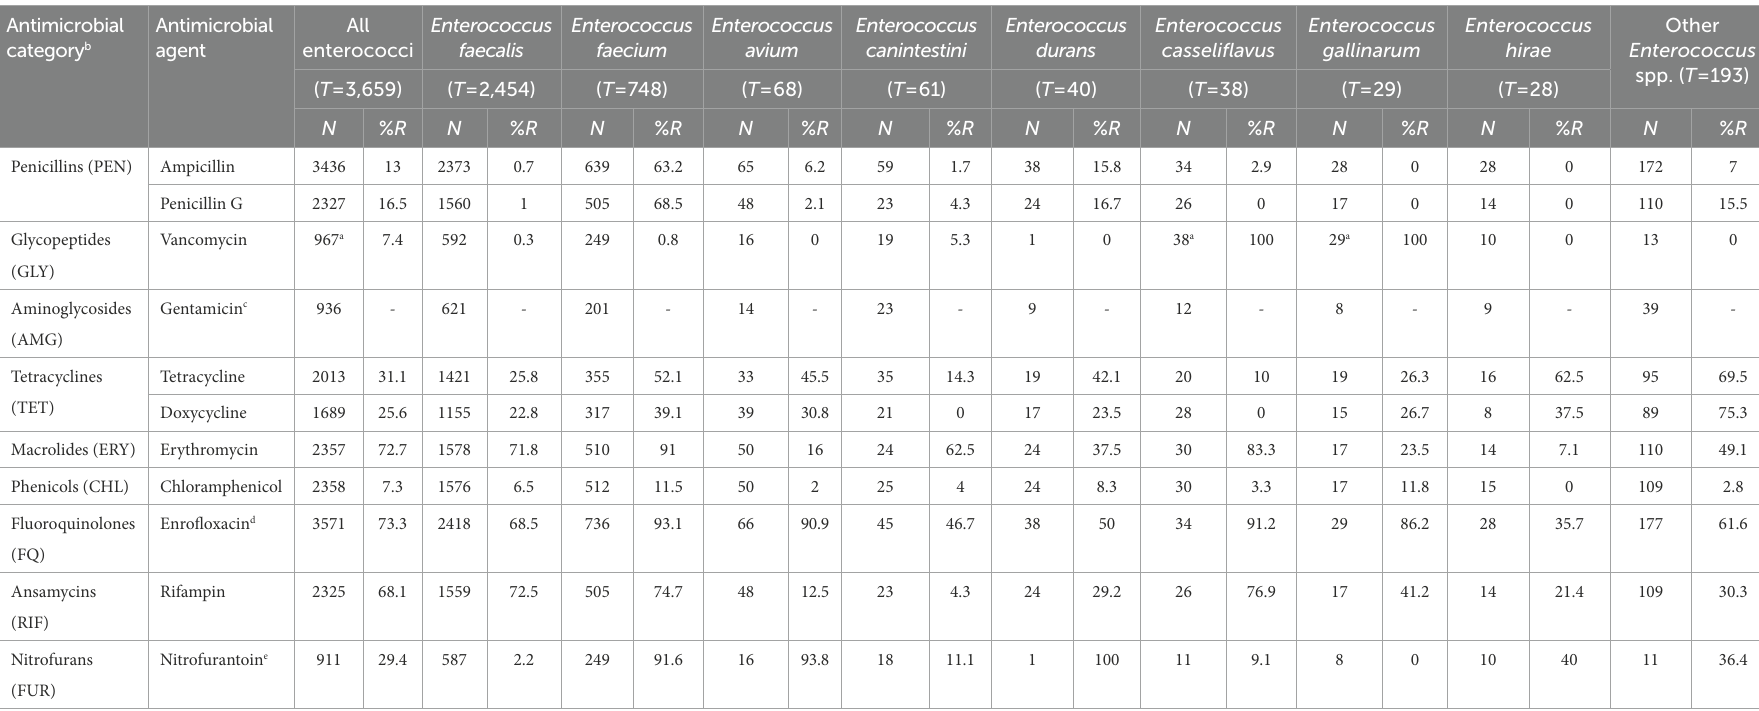
TABLE 1 Prevalence of antimicrobial resistance among Enterococcus spp. clinical isolates from dogs stratified by species, from canine clinical infections at the Cornell University Animal Health Diagnostic Center (AHDC), 2007–2020. Antimicrobial category